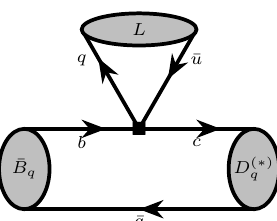
Figure 2 . Leading-order Feynman diagram contributing to the hard kernels T ij ( u ) , where the local four-quark operators are represented by the black square.